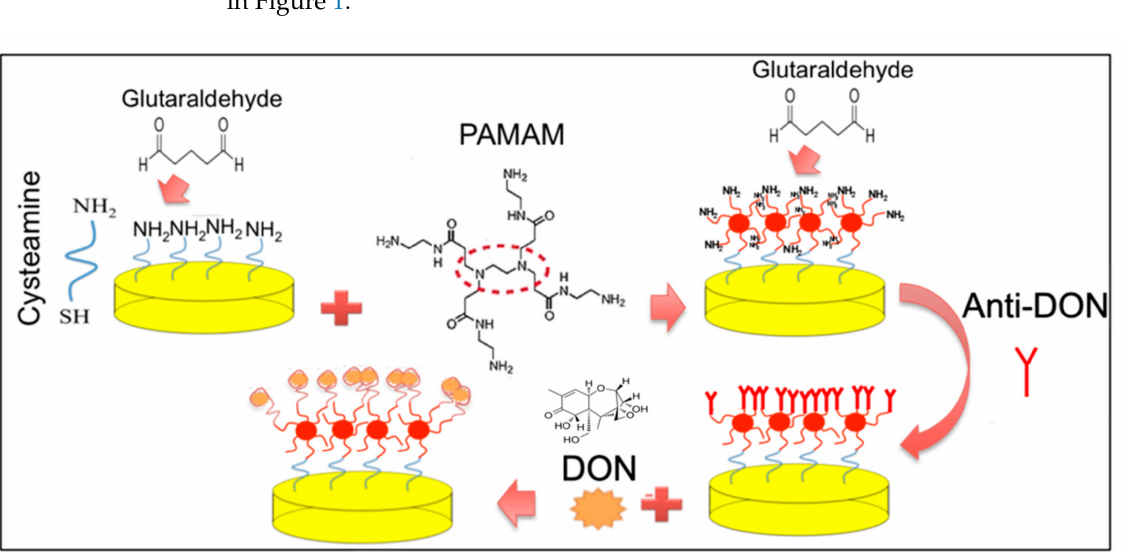
Figure 1. Immunosensor fabrication steps followed by the measurement